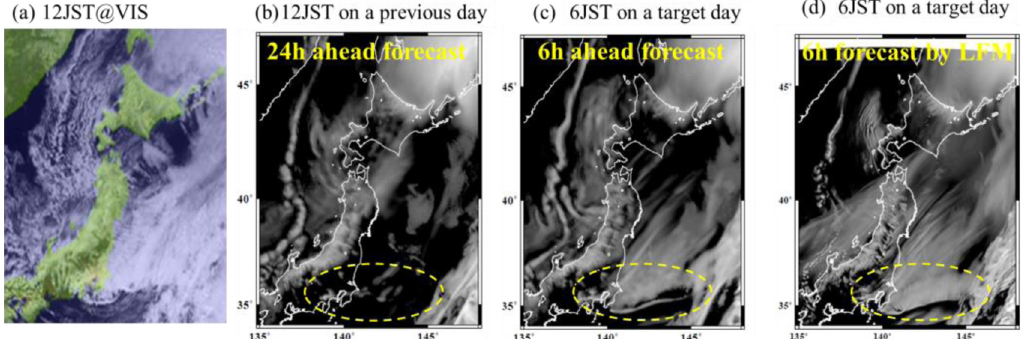
Fig. 4. Comparison of cloud fi elds at 12JST on March 14, 2014. (a) Satellite visible image (close-up view of the yellow square shown in Fig. 2b), (b) 24h forecasts from the MSM, (c) 6 h forecasts from MSM and (d) 6 h forecast from